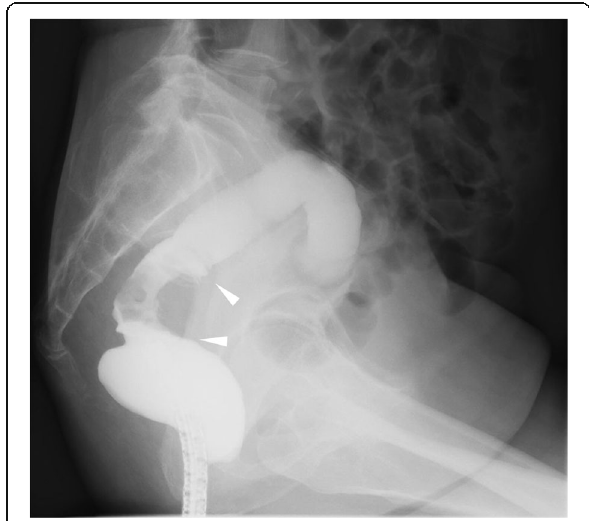
Fig. 3 Barium contrast enema revealing the tumor site (arrow) of the rectum (Ra)